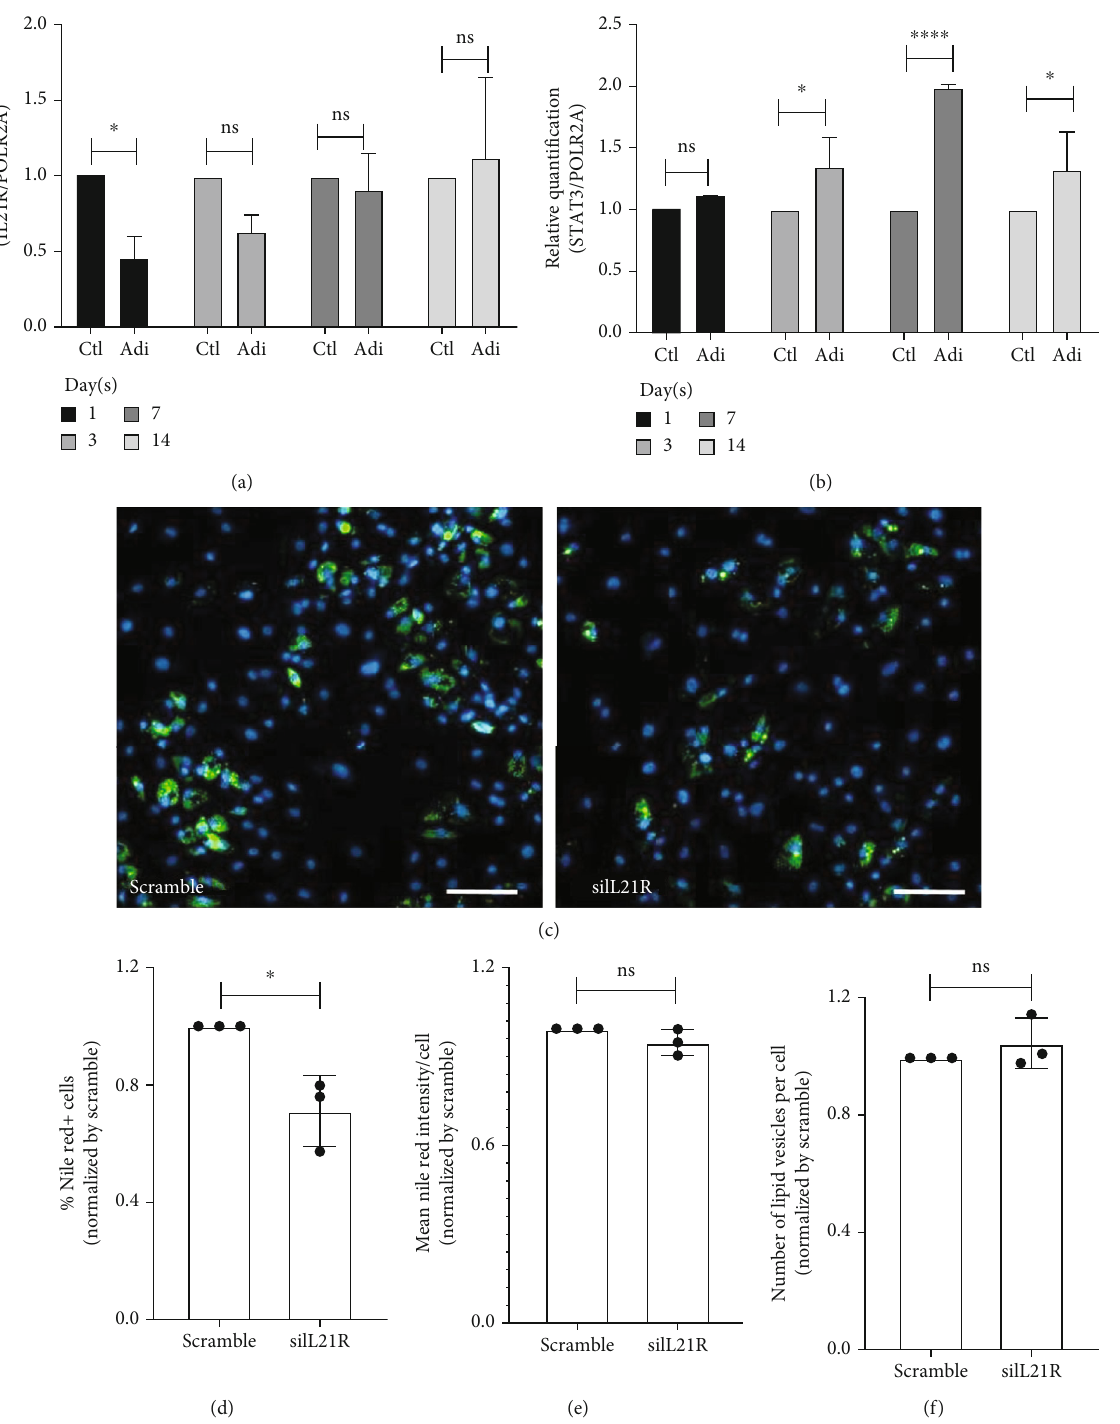
Figure 4: IL21R gene is modulated during adipogenesis, which is a ff ected by gene silencing. (a, b) Relative quanti fi cation of mRNA IL21R and STAT3 during adipogenesis in ADSCs, measured using qRT-PCR. The data were performed in biological and technical triplicate (TAL01, 09, and 32), normalized by POLR2A . Mean with SEM, two-way ANOVA with multiple comparisons: ∗ p < 0 : 05 , ∗∗∗∗ p < 0 : 0001 , ns: not signi fi cant. (c – f) siRNA-treated cells were induced to adipogenesis for ten days. The cells were then incubated with Nile Red (lipophilic fl uorescent dye) and analyzed using the Operetta High-Content Imaging System (TAL23, 27, and 32). (c) Representative fl uorescence images of ADSCs silencing IL21R and scramble after ten days of adipogenesis and stained with Nile Red (green staining) and DAPI (blue staining), representative images of the donor TAL23. Scale bar: 200 μ m. (d, f) Nile Red fl uorescence quanti fi cation of ADSCs silenced for IL21R and induced to adipogenic di ff erentiation for ten days. (d) Percentage of Nile Red positive cells, (e) mean fl uorescence intensity per cell, and (f) the number of lipid vesicles per cell. Mean with SEM; Student ’ s unpaired t -test analysis: ∗ p < 0 : 05 , ns: not signi fi